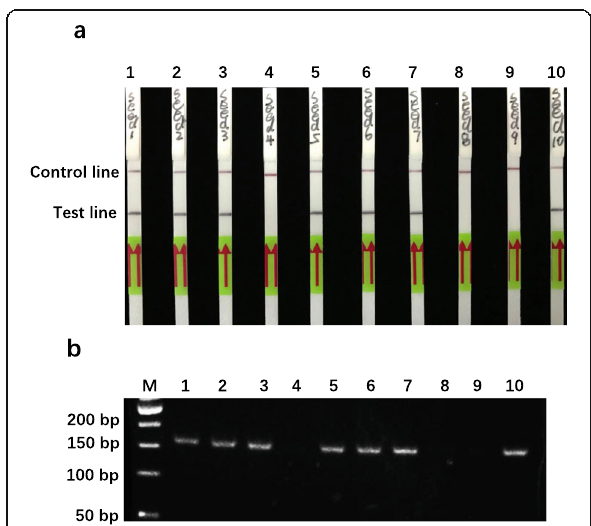
Fig. 5 Detection of BCMV in adzuki bean seeds using RPA-LFD and PCR. cDNA obtained from 10 adzuki bean seeds from infected parental plants were used as templates for detection of BCMV by both RPA-LFD ( a ) and PCR methods ( b )